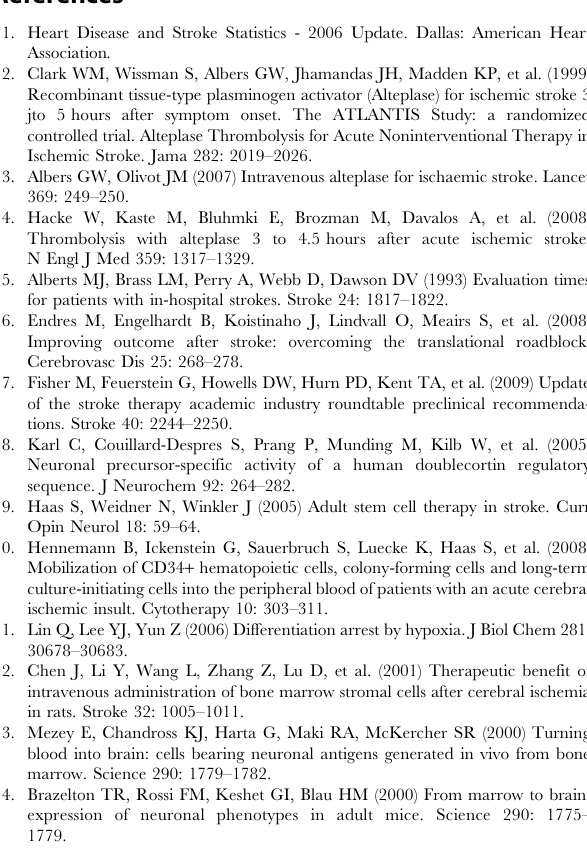
to include when reporting a randomised